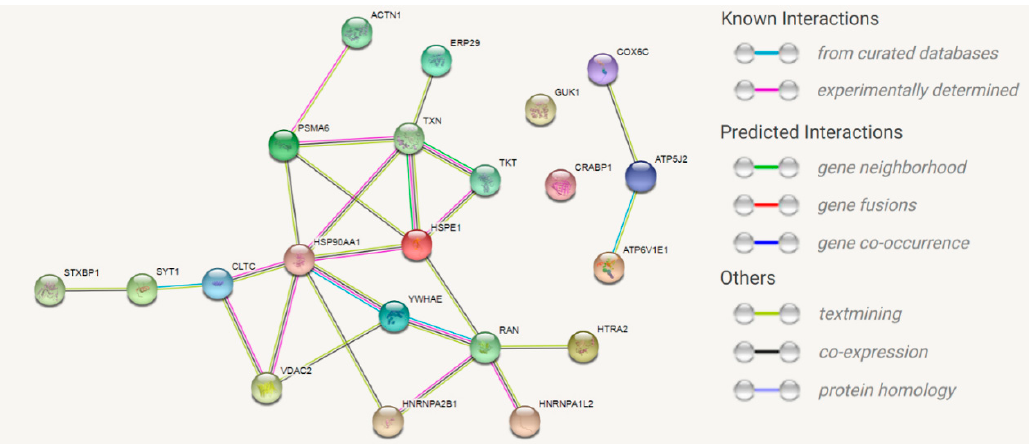
Figure 5. Analysis of the CDR-induced signaling pathways in the retinal explants after 24h of incubation. Search Tool for the Retrieval of Interacting Genes/Proteins (STRING) shows the signaling pathways of the most significantly changed proteins using the medium confidence score (0.4). Epitope target HTRA2 shows at least a text-mining and co-expression to GTP-binding nuclear protein RAN. Table 1. List of CDR-induced top canonical pathways revealed by Ingenuity Pathway Analysis (IPA). Canonical Pathway − Log ( p -Value) Molecules Protein Ubiquitination Pathway